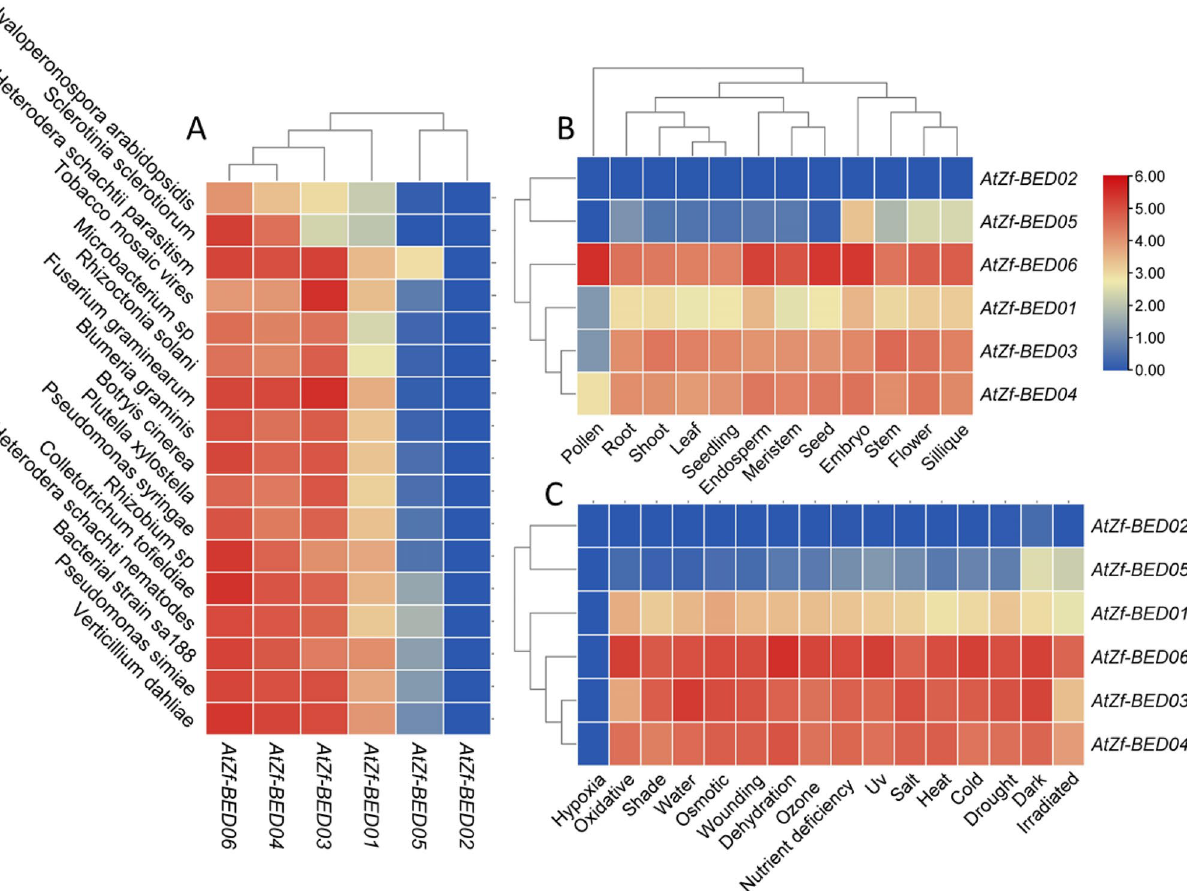
Figure 7. Expression profiling of AtZF-BED s. ( A ) under various biotic stresses, ( B ) in different tissues, ( C ) under different abiotic